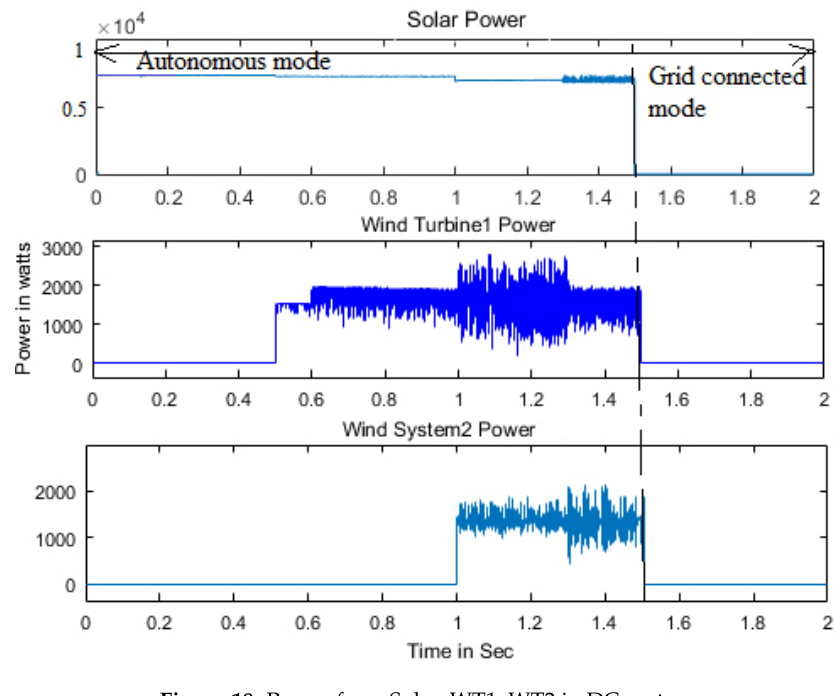
Figure 18. Power from Solar, WT1, WT2 in DC system.